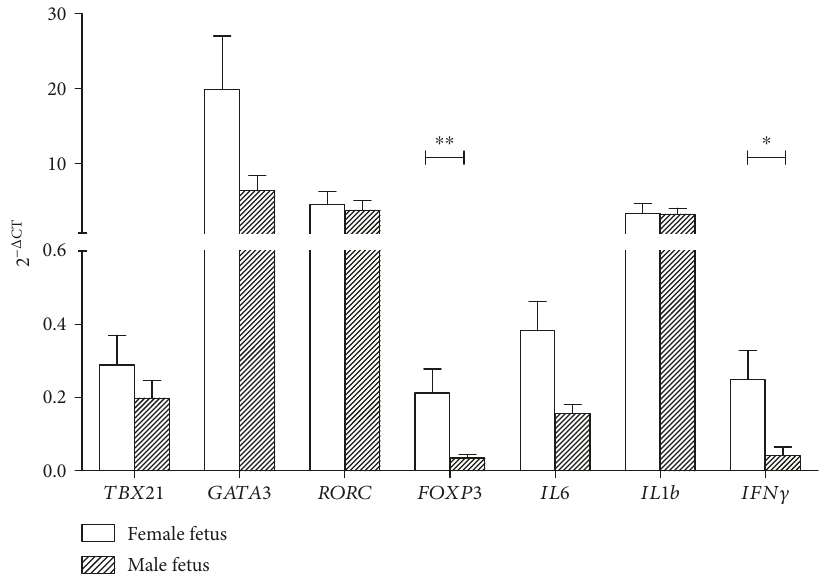
Figure 1: mRNA expression of T-lymphocyte markers and cytokines in the fi rst-trimester human decidual tissue. Data are mean ± SEM mRNA target gene expression normalized to housekeeper gene HPRT , in the decidual tissue from pregnancies with a female fetus (open bars, n = 8 ) and pregnancies with a male fetus (black bars, n = 8 ). Comparison between groups was evaluated using Mann – Whitney U test with Bonferroni multiple comparison corrections; ∗ p < 0 05 , ∗∗ p < 0 01